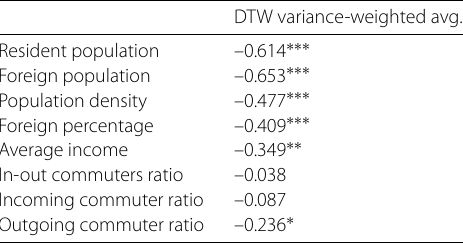
Table 3 Spearman correlation between the variance-weighted average of the DTW distances and (i) resident population (absolute number), (ii) foreign population (absolute number), (iii) population density, (iv) percentage of foreigners per resident population, (v) yearly average income per tax payer, (vi) ratio between commuters coming to a city and commuters leaving a city, (vii) percentage of incoming commuters per resident population, and (viii) percentage of outgoing commuters per resident population ( p ≤ 0.05: ∗ , p ≤ 0.01: ∗∗ , p ≤ 0.001: ∗∗∗ ) DTW variance-weighted